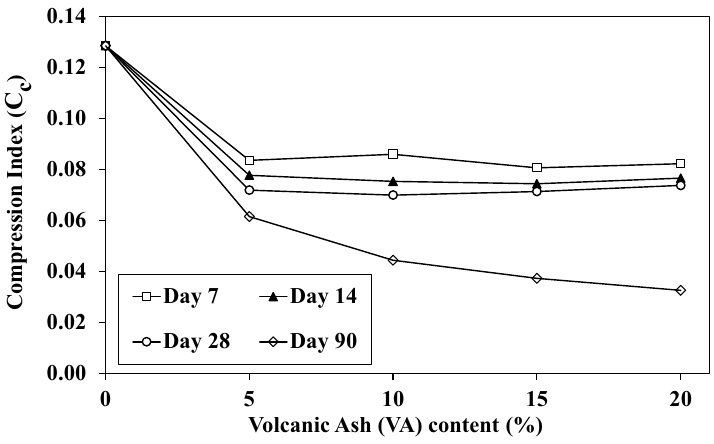
Figure 18. Influence of the volcanic ash (VA) on the compression index (C c ) with the curing time.